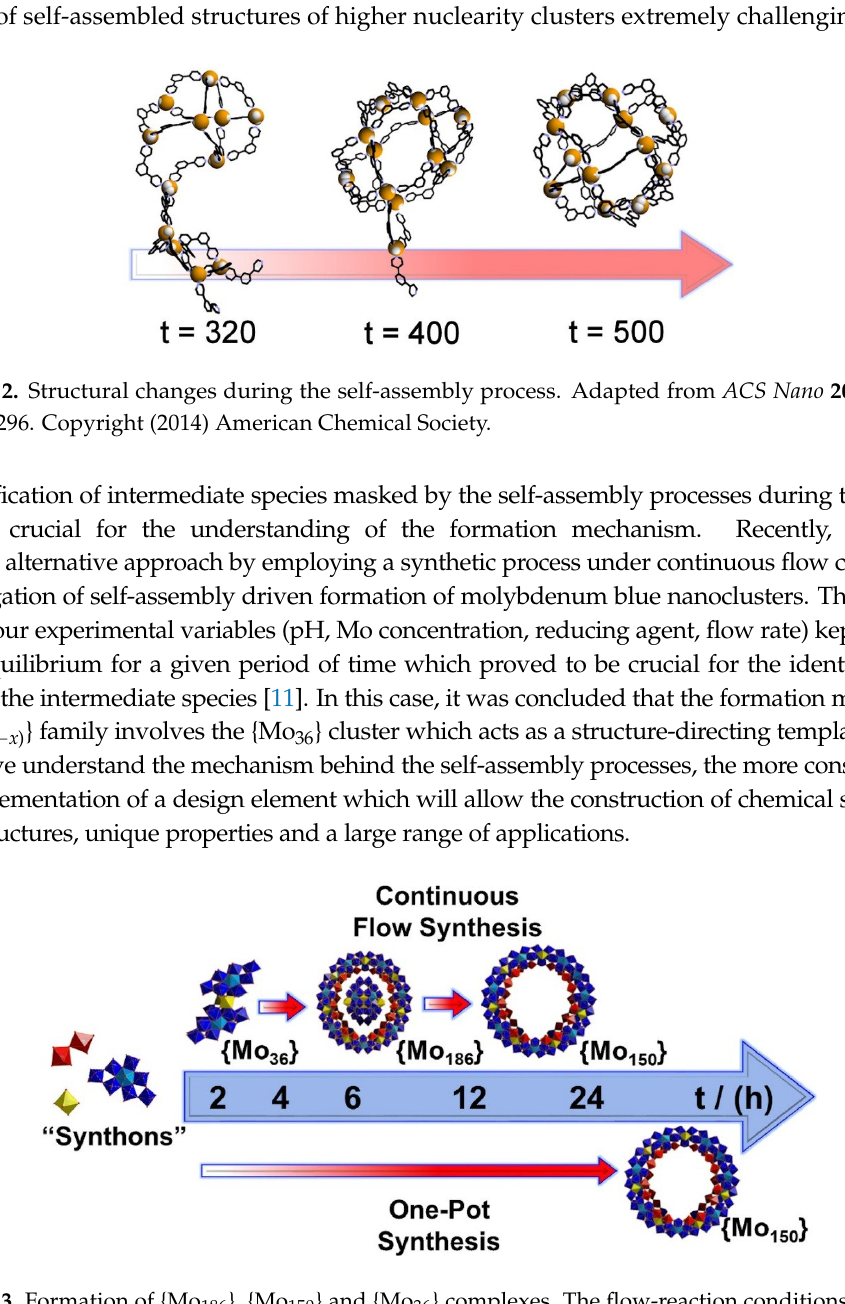
Figure 3. Formation of {Mo 186 }, {Mo 150 } and {Mo 36 } complexes. The flow-reaction conditions and the reducing environment are necessary factors for the isolation of {Mo 36 }. Colour scheme, yellow: {Mo 1 }, red; {Mo 2 }, blue; {Mo 8 }.